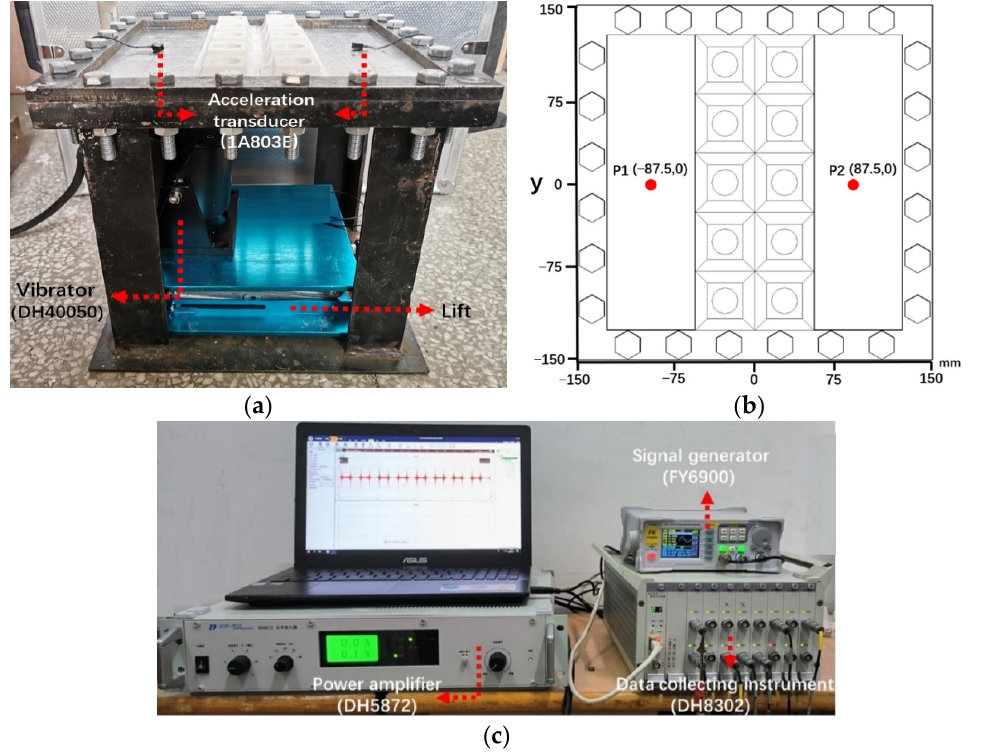
Figure 11. Snapshot of the experimental setup: ( a ) overall experimental model; ( b ) local details of the experimental model; ( c ) test